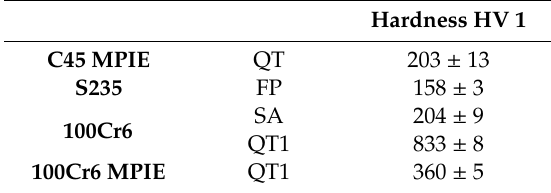
Table 3. Material hardness resulting from the heat treatments listed in Table